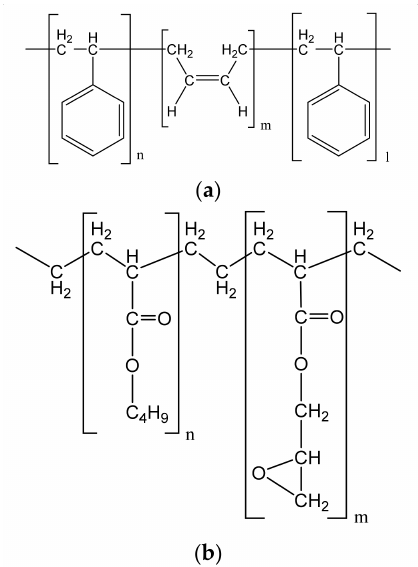
Figure 4. The structural formulas of ( a ) SBS and ( b ) Elvaloy polymers.